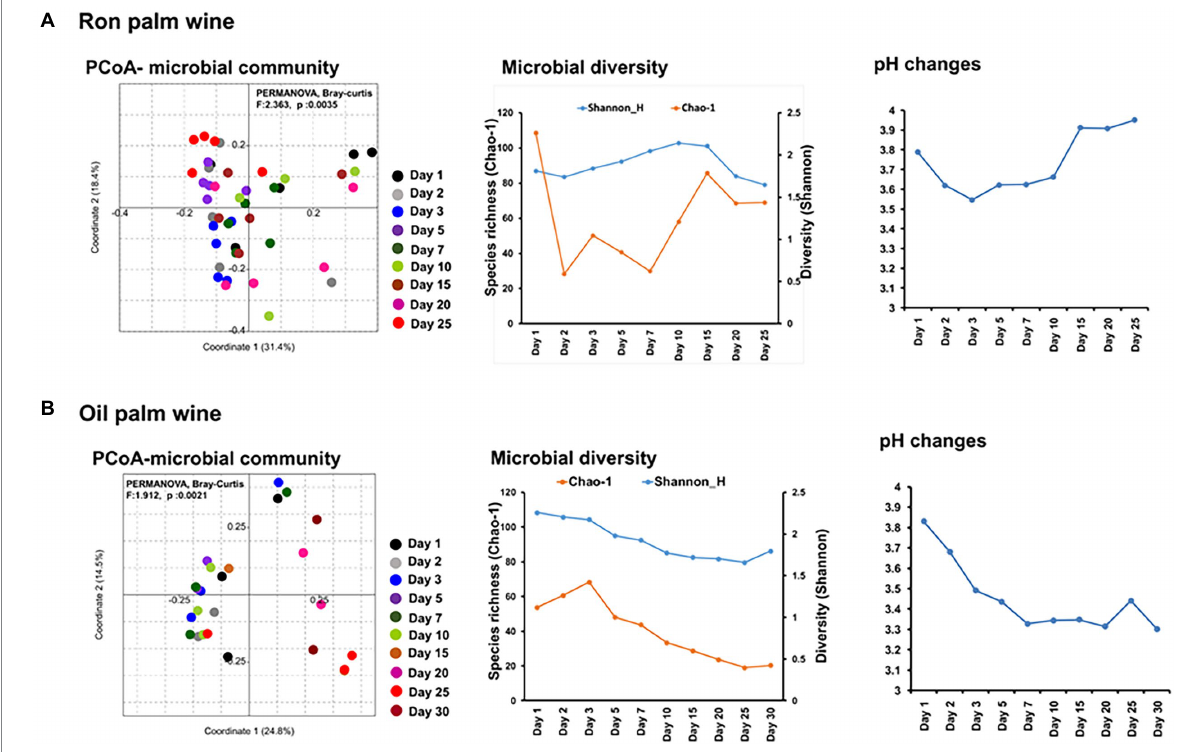
FIGURE 2 Dynamics in the microbial community structure, diversity and pH during spontaneous fermentation of palm wine tapping from ron palm (A) and oil palm (B) wine tapping days. PCoA based on Bray–Curtis dissimilarity based on the relative abundance of species-level OTUs, alpha diversity analysis (Chao-1 and Shannon indices) and pH readings of the stage-wise collected samples shows dynamics during 25 days of spontaneous ron palm wine tapping and 30 days of oil palm wine tapping. The significance in the stage wise difference in PCoA is expressed as Bonferroni corrected p -values. PERMANOVA: Permutational multivariate analysis of